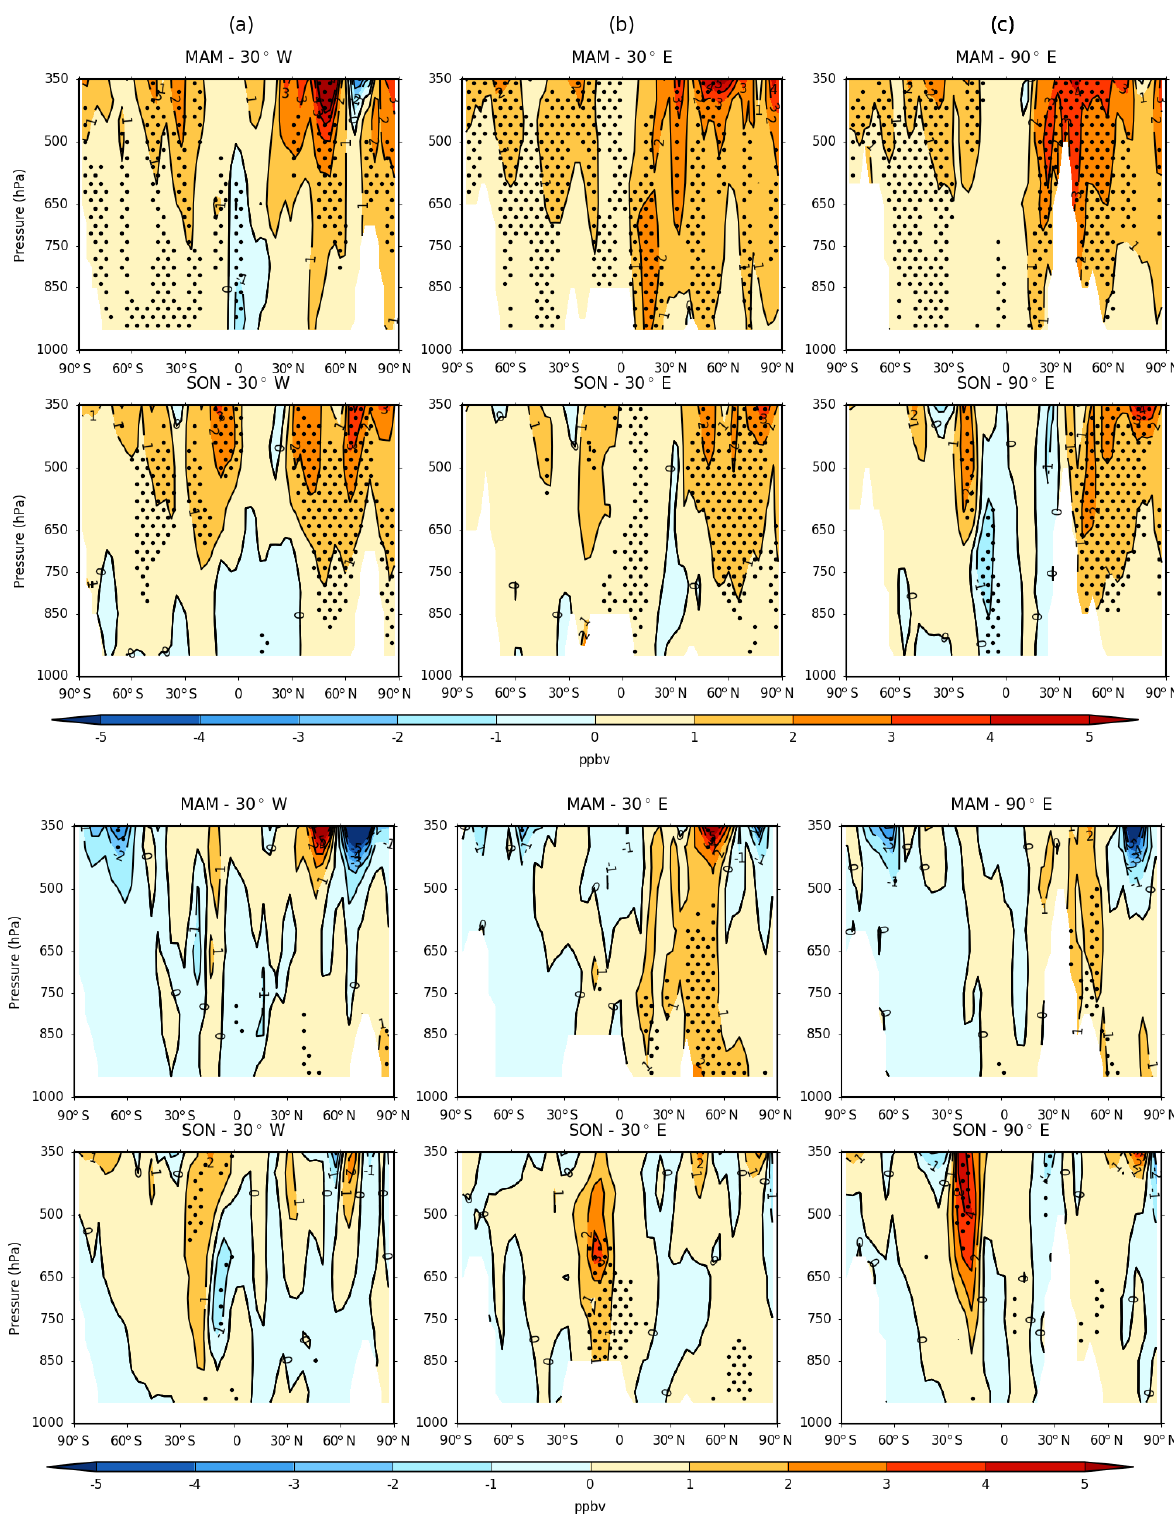
Figure 11. Longitudinal cross sections of the seasonal change in the vertical distribution of stratospheric ozone (O 3 S) VMR (ppbv) from EMAC (top) and CMAM (bottom) between 1980–1989 and 2001–2010 for MAM and SON at (a) 30 ◦ W, (b) 30 ◦ E and (c) 90 ◦ E. Stippling denotes regions of statistical significance according to a paired two-sided t test ( p < 0 .